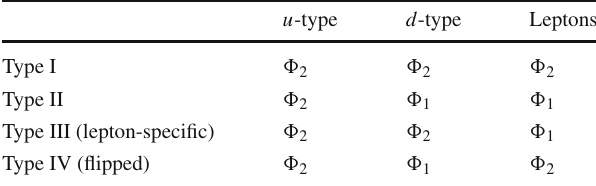
Table 1 Allowed fermion couplings in the four types of 2HDM u -type d -type Leptons Type